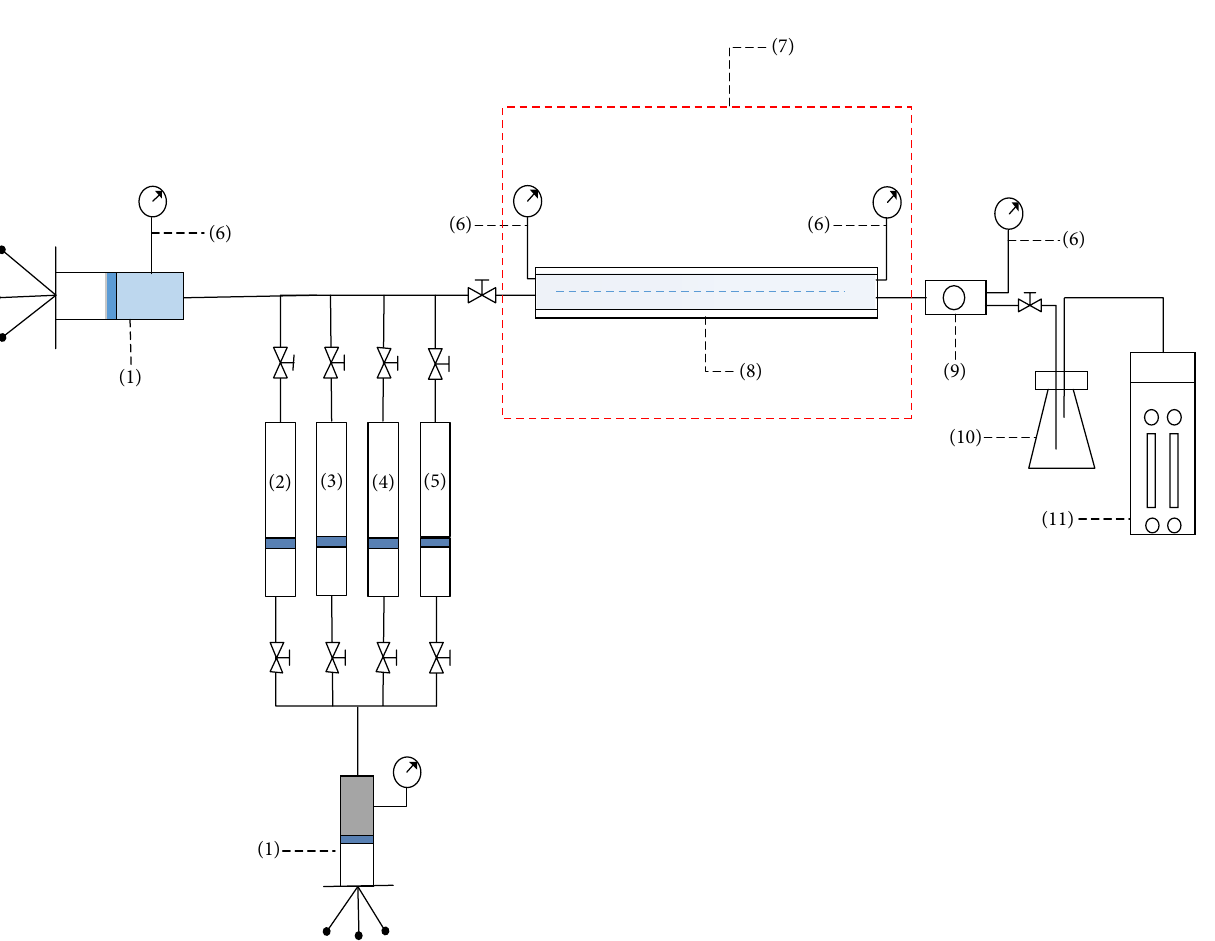
Figure 2: Schematic diagram of the core flooding apparatus. ( 1 ) Pump, ( 2 ) Na 2 CO 3 solution, ( 3 ) NaHCO 3 solution, ( 4 ) acid, ( 5 ) compound surfactant, ( 6 ) pressure gauge, ( 7 ) thermostatic air bath, ( 8 ) sand pack tube, ( 9 ) back pressure regulator, ( 10 ) oil and water collector, and ( 11 ) gas meter.